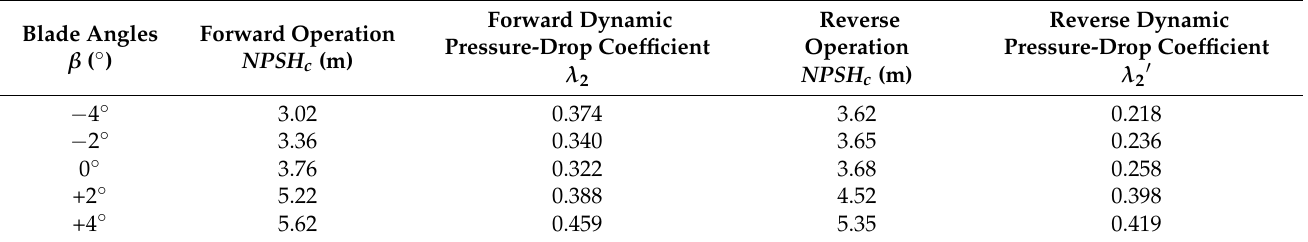
Figure 14. Variation of the λ 2 / λ 2 m ( λ 2 (cid:48) / λ (cid:48) 2 m for reverse) with Q / Q 0 ( Q (cid:48) / Q (cid:48) 0 for reverse) for blade angle β = 0°.